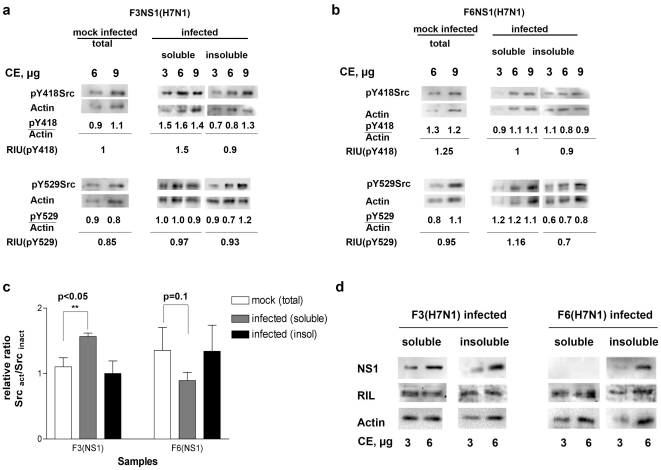
The activation state of cellular Src during infection is differently modulated by H7N1 viruses expressing the full length or the truncated NS1 protein.a. A representative Western blot analysis of the active (Y418 phosphorylated) or inactive (Y529 phosphorylated) forms of Src in cells infected with the with natural 977 H7N1 strain expressing full length NS1. Intensities normalized to the actin controls are indicated below each corresponding lane. Mean values for the intensities normalized to actin are indicated below each set as relative intensity units (RIU). b. as in panel a, but for cells infected with the 4426 virus expressing the F6?221-230 NS1 protein. c. Normalized RIU values for each form, were used to derive the relative ratios for active vs. inactive Src. Values are the means derived from the western blots of two independent infection experiments, as exemplified in panels a and b. Each western blot has been loaded with two (mocked) or three (infected) different amounts of crude extract, in order to obtain replicated measurements for each infection experiment. Error bars are ±S.D. d. Western blot analysis of NS1 and RIL proteins in the cell extracts used for the experiments shown in panels a and b.